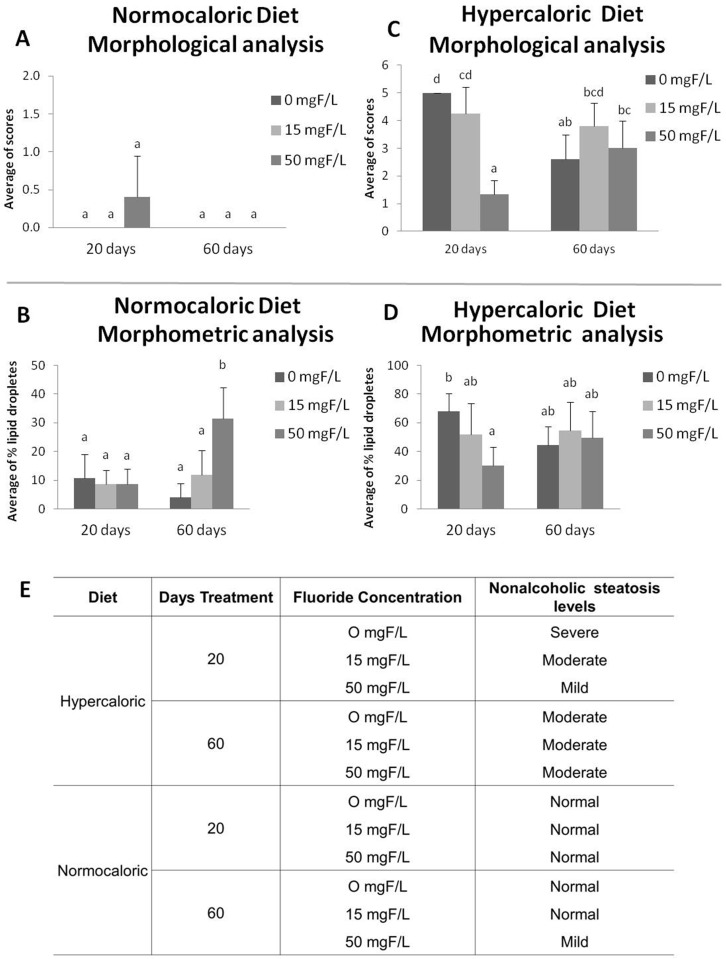
Histological analysis: A) and C). Average of scores found in the liver of animals in relation to the type of diet, based on Score photomicrograph of liver. B) and D). Morphometric analysis average of % lipid droplets found in the liver of mice in relation to the diet. E) Nonalcoholic steatosis level in each group of treatment: normal ≤12.9%, mild 13–37.9%, moderate 38–61.3% and severe ≥61.4%, based on morphometric analysis.